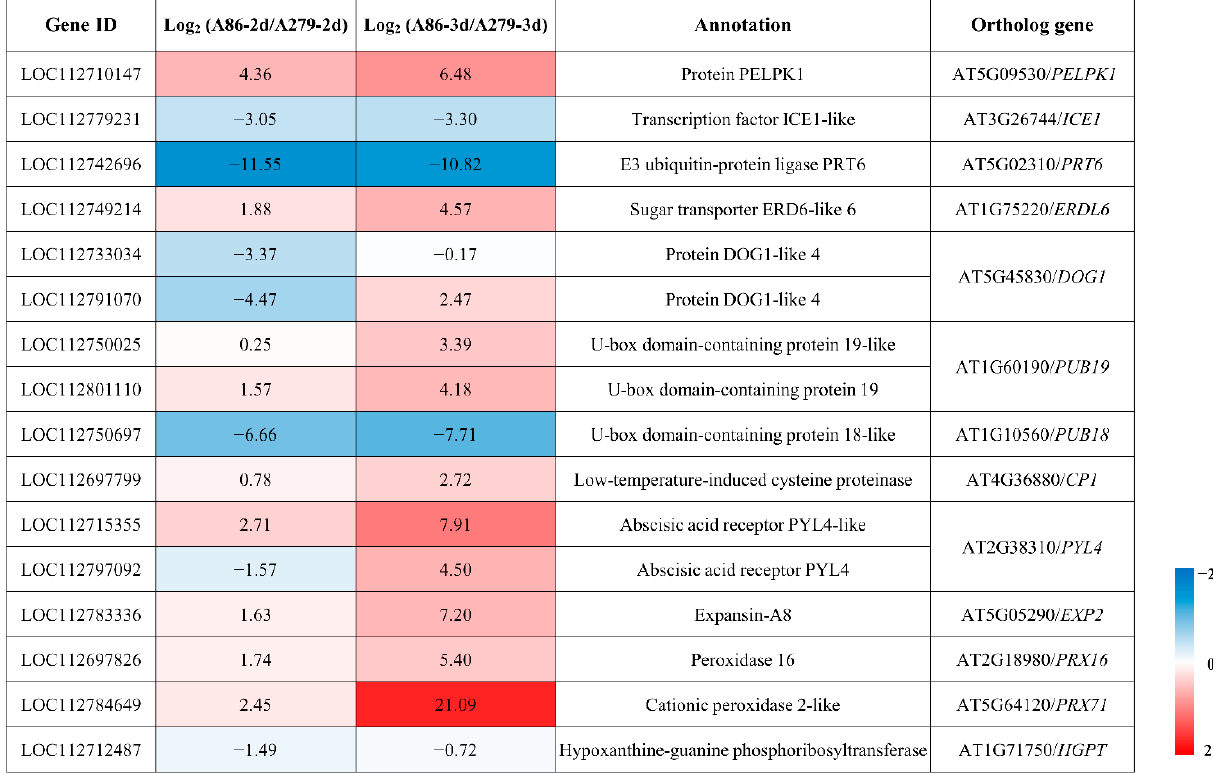
Figure 9. The qRT ‐ PCR validations. ( A ) AhIAA14 . ( B ) AhEXT . ( C ) AhEXP . The relative expression levels of the three DEGs were calibrated against those of the Actin gene quantified by qRT ‐ PCR.